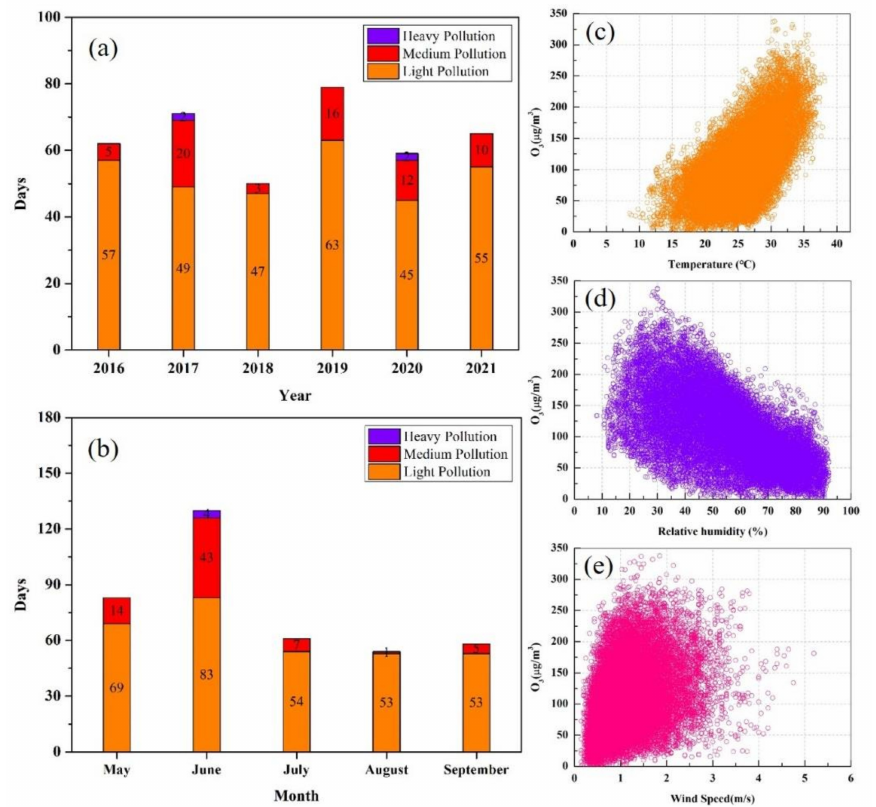
Figure 3. The number of days of O 3 pollution in different levels in Tai’an for ( a ) the annual values from 2016 to 2021 and ( b ) monthly values during May–September from 2016 to 2021, scatter plots between hourly O 3 concentrations and temperature ( c ); relative humidity ( d ); and wind speeds ( e ) in Tai’an during May–September from 2016 to